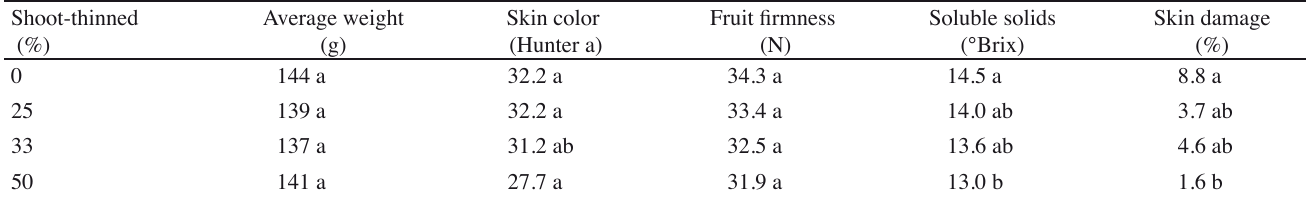
Table 5 - Effect of summer pruning severity on 29 July on fruit characteristics of ‘Nishimurawase’ persimmon harvested on 26 September (Choi et al ., 2003